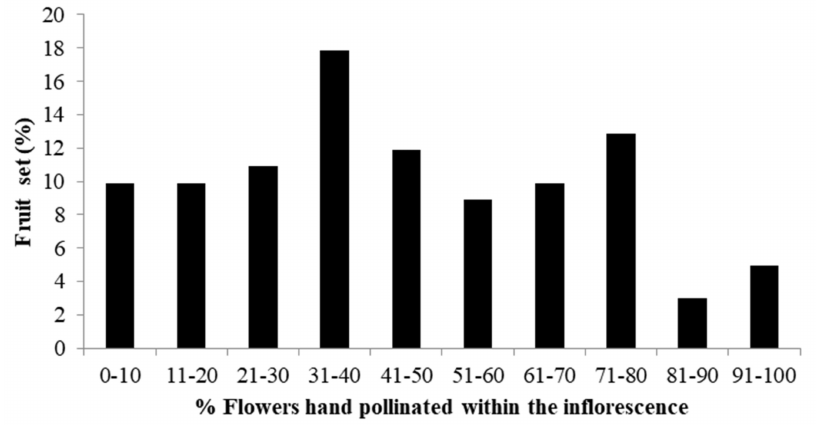
Figure 8. Percentage of fruit set obtained based on the percentage of hand-pollinated flowers in the